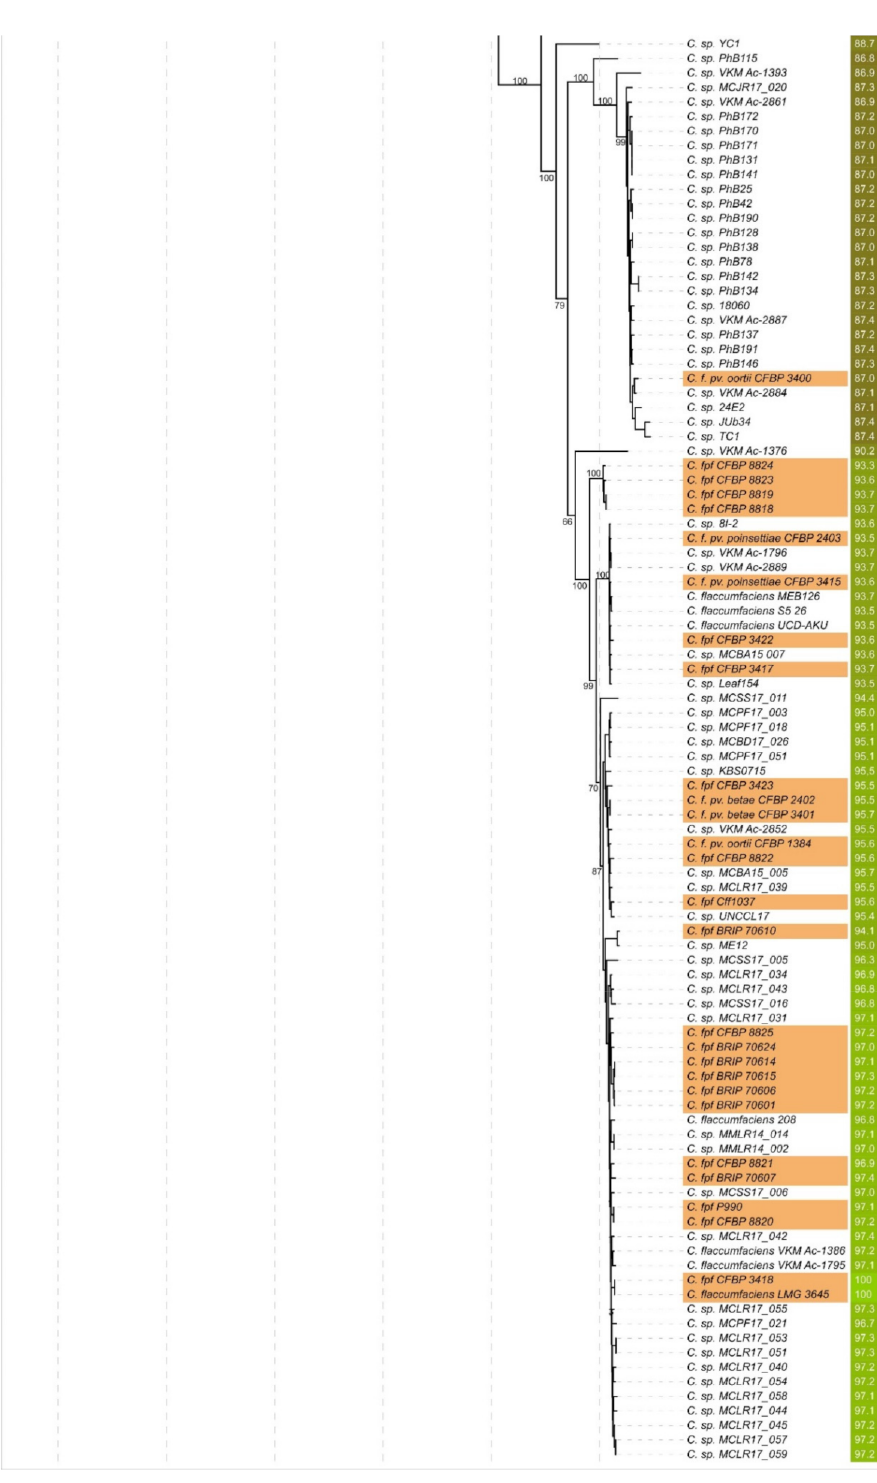
Figure 3. Best-scoring phylogenetic trees obtained with RAxML using concatenated nucleotide se- quences’ alignments of ribosomal proteins extracted from 190 Curtobacterium genomes and Gryllotalpi- cola ginnsengisoli DSM 22003. The abbreviations are as follows: C .— Curtobacterium , G .— Gryllotalpicola , C. f. — Curtobacterium flaccumfaciens , and C. fpf — flaccumfaciens pv. flaccumfaciens . The C. fpf